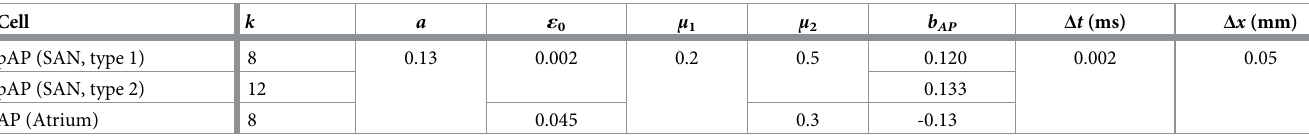
Table 2. Parameters for the pAP and AP models used in the 2D SAN simulations.